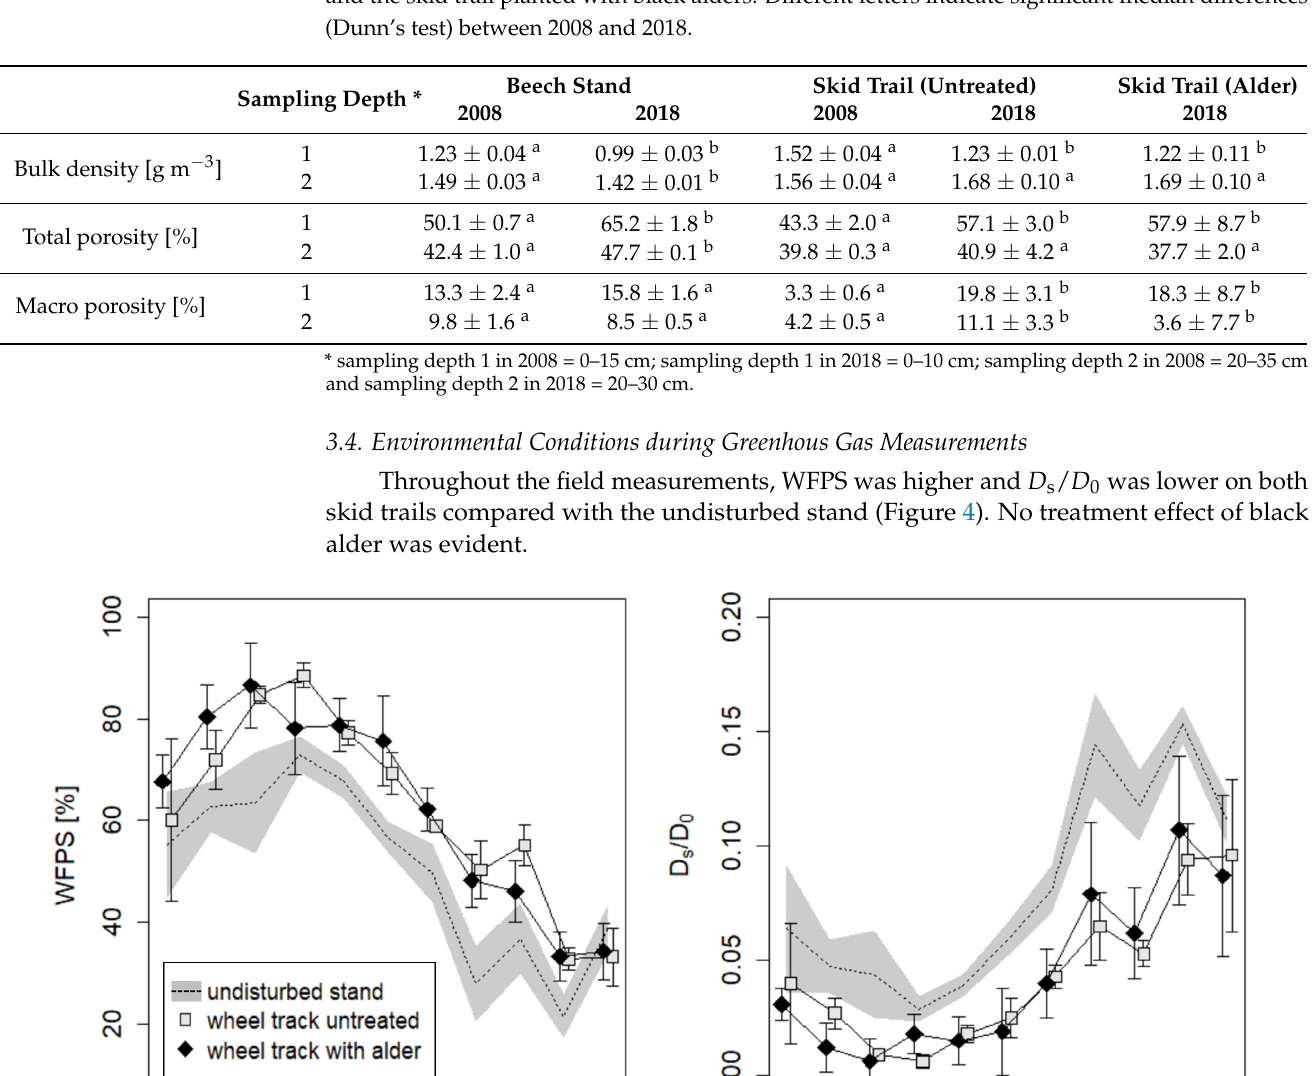
Table 1. Median values of bulk density, total porosity and macro porosity and their 95% confidence interval in the undisturbed beech stand (control) and on the wheel track of the untreated skid trail and the skid trail planted with black alders. Different letters indicate significant median differences (Dunn’s test) between 2008 and 2018.